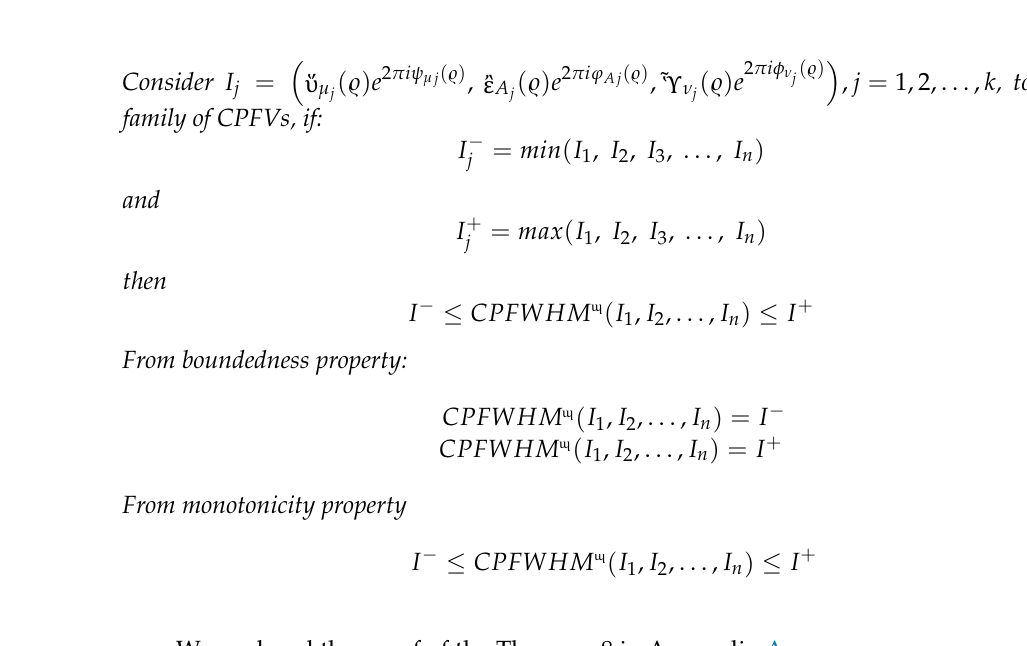
Table 1. Symbols and their